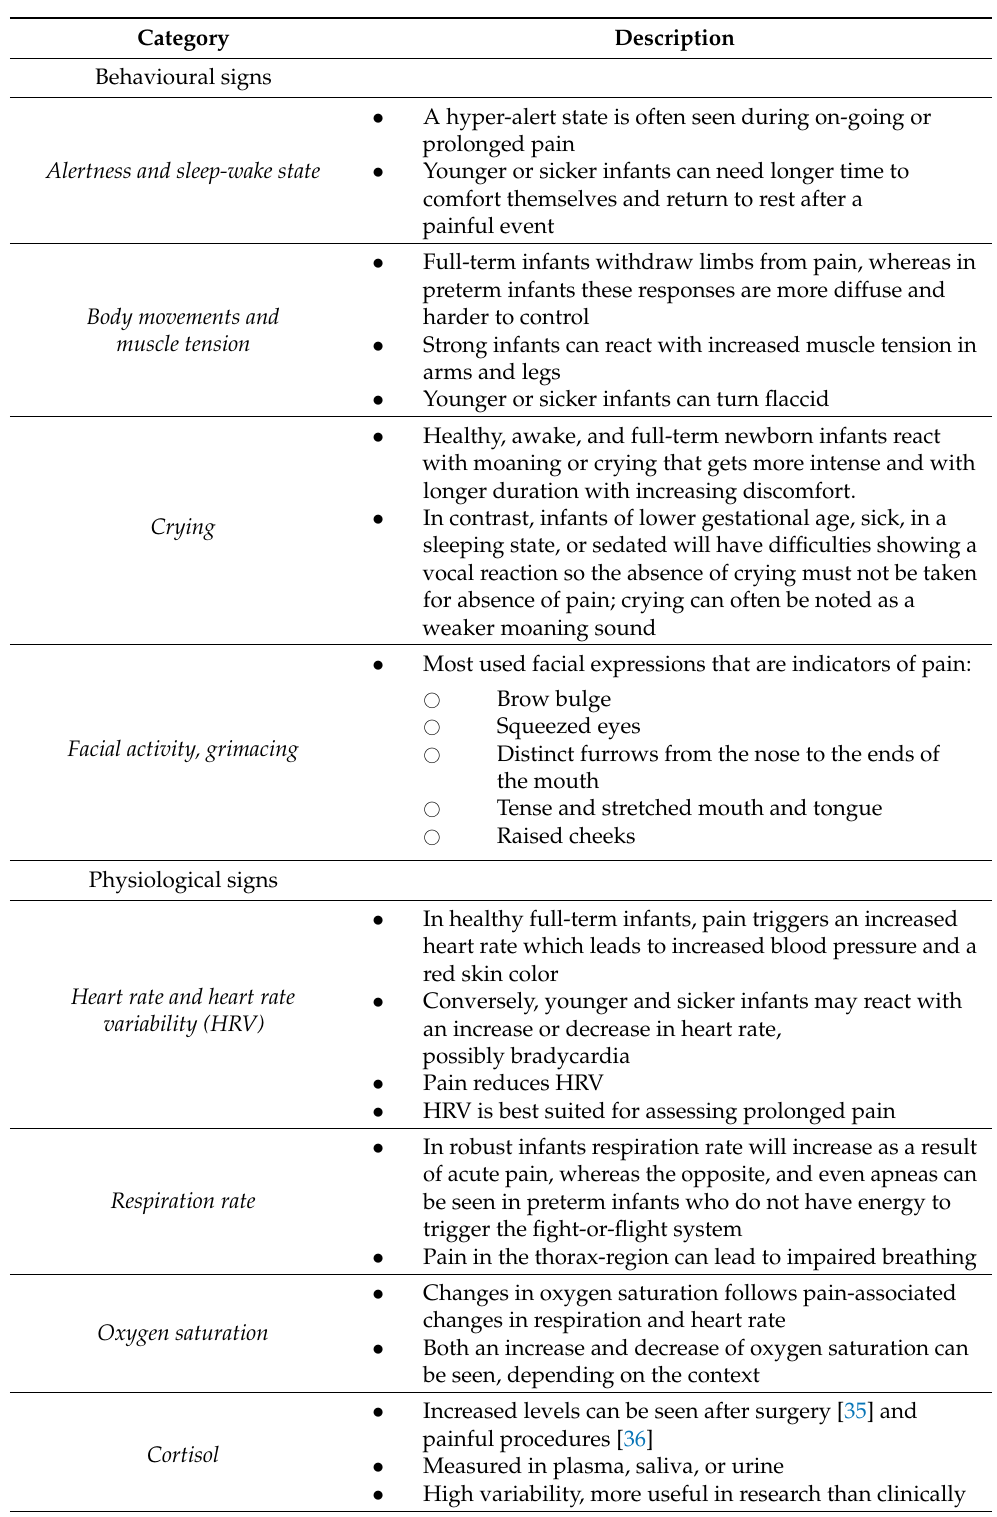
Table 1. Indicators of neonatal